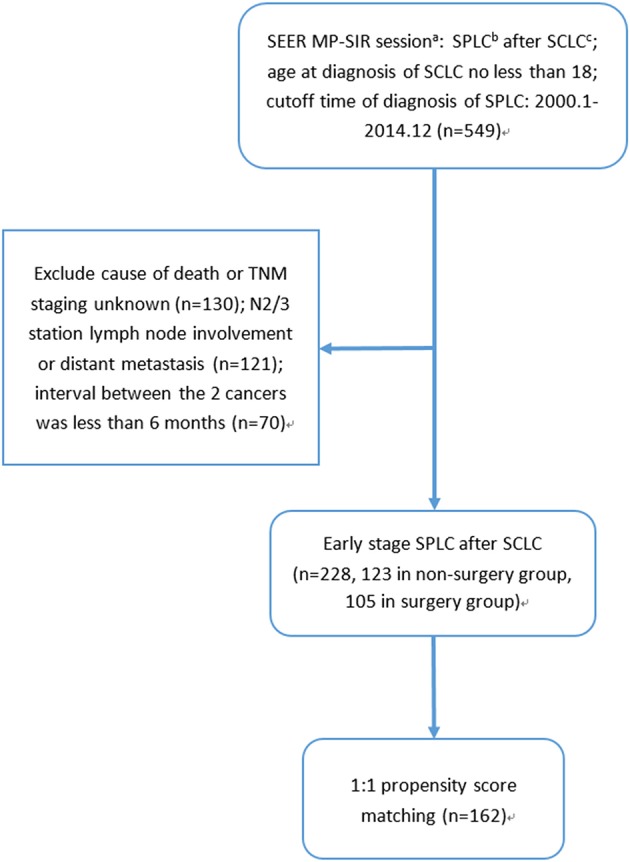
Selection flow: (a) SEER MP-SIR: Surveillance, Epidemiology, and End Results (SEER) Multiple Primary Standardized Incidence Ratios (MP-SIR) session specializes in conducting an analysis examining multiple subsequent cancers. (b) SPLC: second primary non-small cell lung cancer after small cell lung cancer. (c) SCLC: small cell lung cancer.